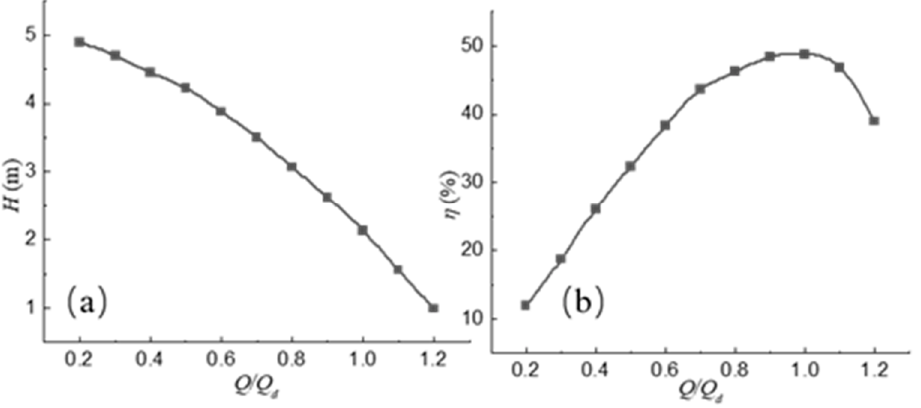
Figure 6. External characteristic curve of inducer: ( a ) head performance curve; ( b ) efficiency performance curve.